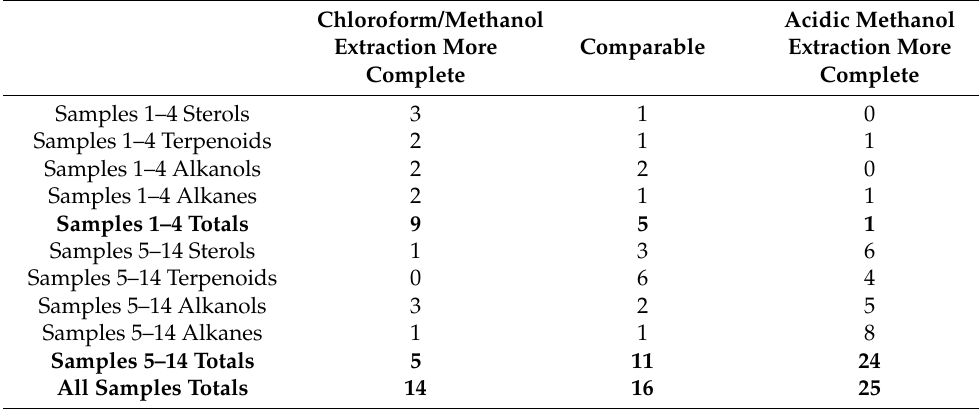
Table 3. Overall success of extraction methods for different compound classes in the study for all samples. Extractions that are more complete either contained compounds that were not present in the other extraction method, or contained more than 1.5 × more of a compound class than the other, measured in µ g lipid/g sherd. Comparable extractions were those in which the compound class was absent in both extractions, or in which the compound class was within 1.5 × of each other in both extractions, measured in µ g lipid/g sherd. Chloroform/Methanol Acidic Methanol Extraction More Comparable Extraction More Complete